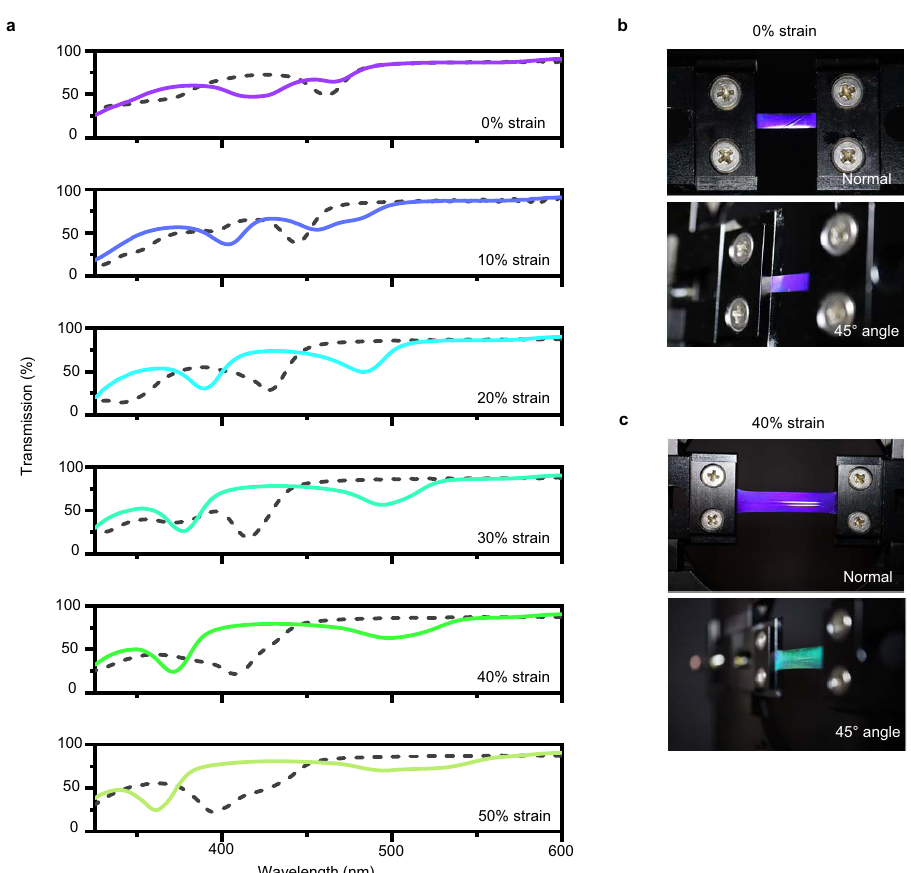
Fig. 4 Optical con fi rmation of BPII LCE lattice asymmetry with deformation. a Transmission spectra of a BPII LCE with the surface of the fi lm at normal incidence to the optical probe [dashed line] and the fi lm angled 45° to the optical probe [solid lines] at uniaxial strains between 0% and 50%. b Photos of unstrained BPII LCE illuminated from camera direction. Top: Sample at normal incidence (bottom) 45° angle. c Photos of 40% strained BPII LCE illuminated from camera direction. Top: Sample at normal incidence (bottom) 45°